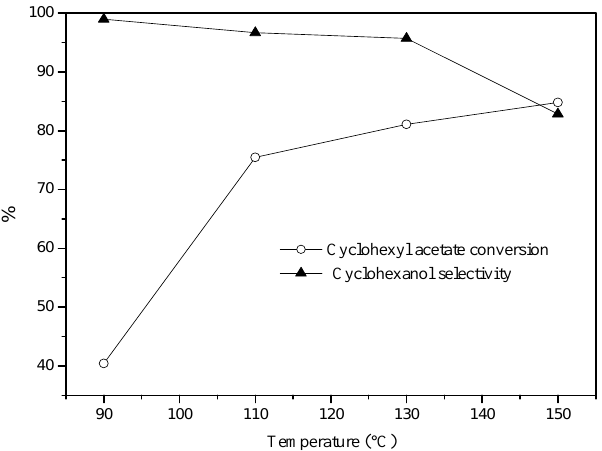
Figure 6. Effect of reaction temperature on the hydrolysis of cyclohexyl acetate over CSALA. Reaction conditions: cyclohexyl acetate 8 mL (55 mmol), H 2 O 24 mL (1333 mmol), CSALA 1.2 g, 5 h.